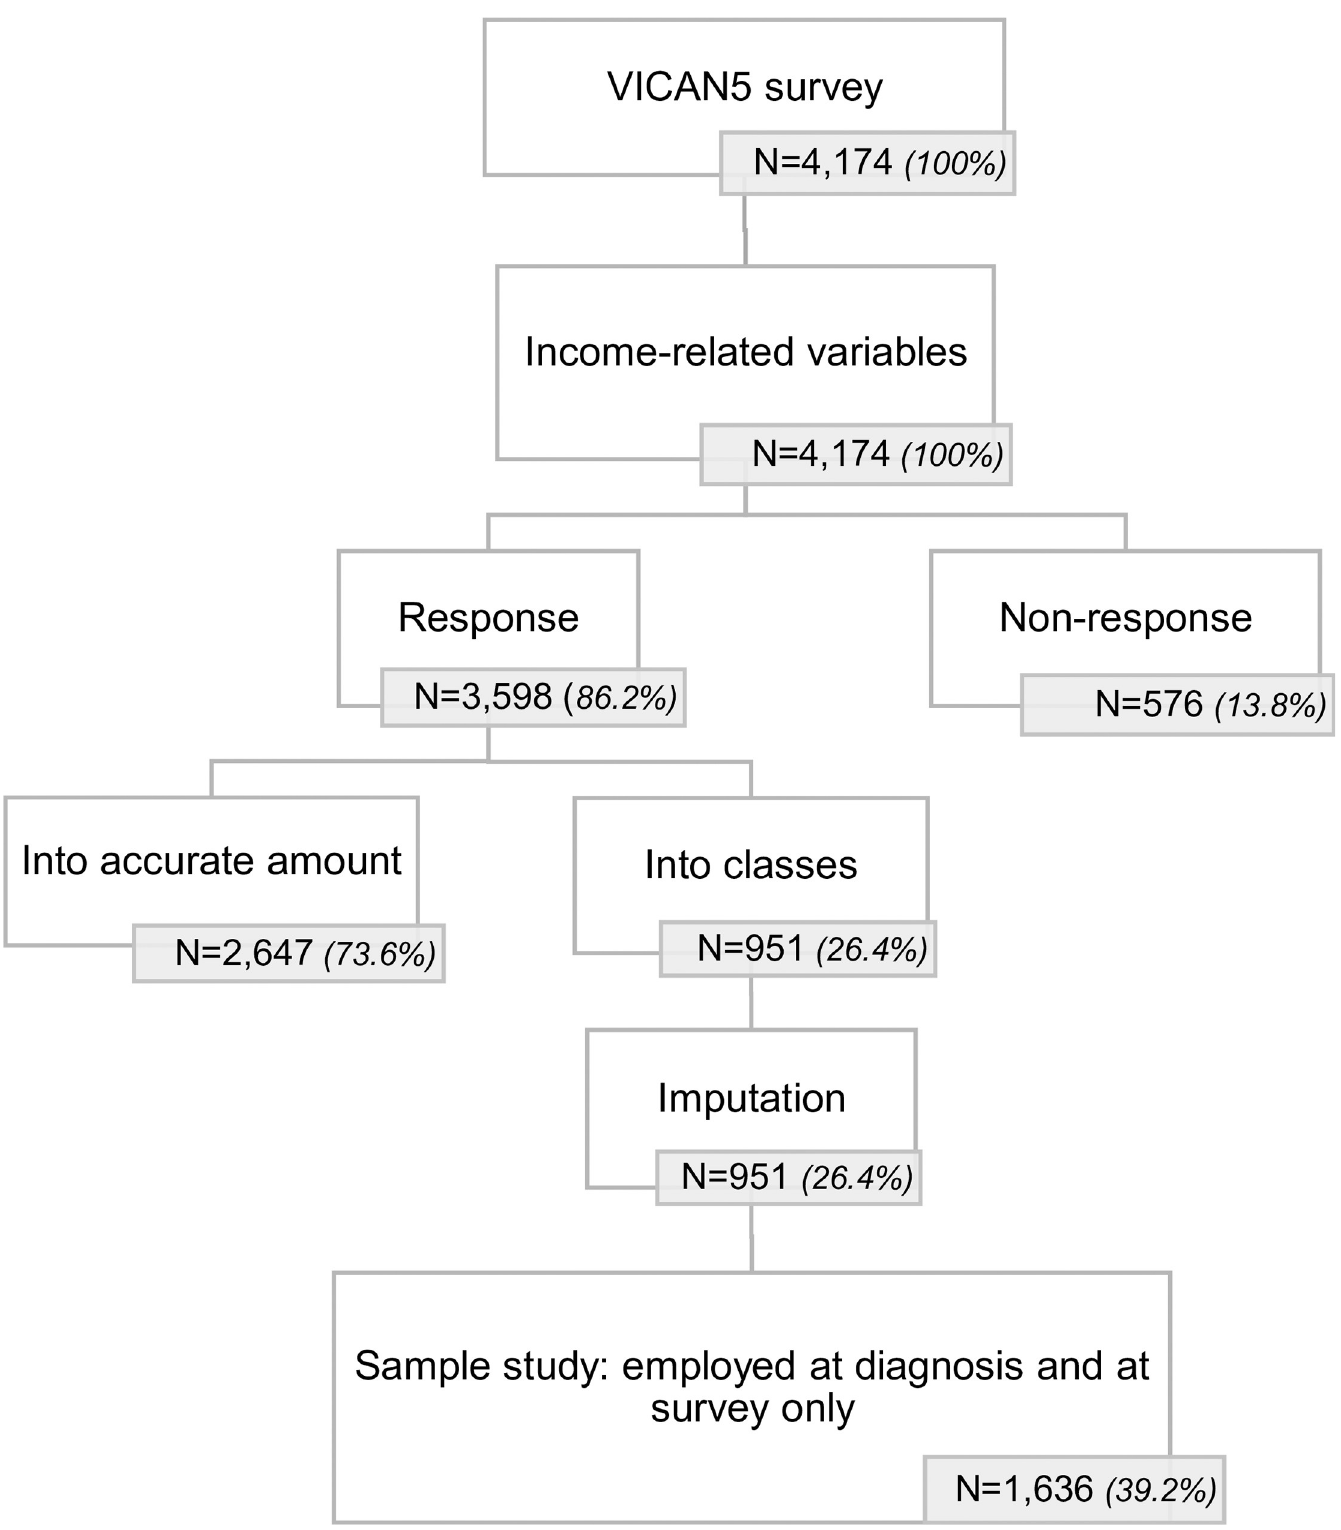
Fig 1. Flow chart of the study population.